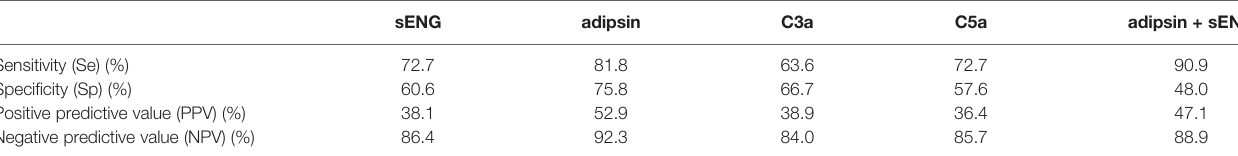
TABLE 2 | Early predictive value of sENG, adispin, C5a, and C3a for preeclampsia.